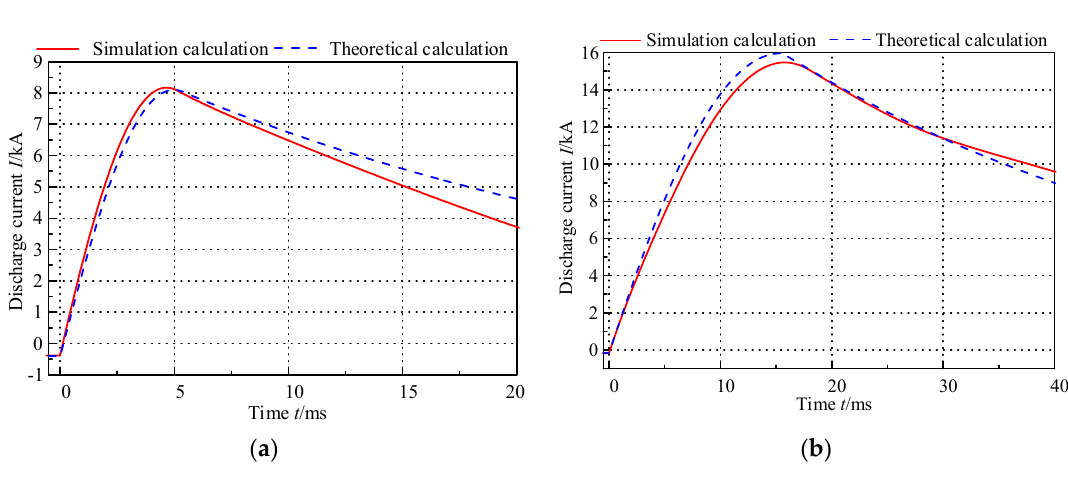
Figure 13. The current waveform under F1 fault by theoretical calculation and simulation calculation: (a) VSC1 discharge current and (b) DCSST1 discharge current.